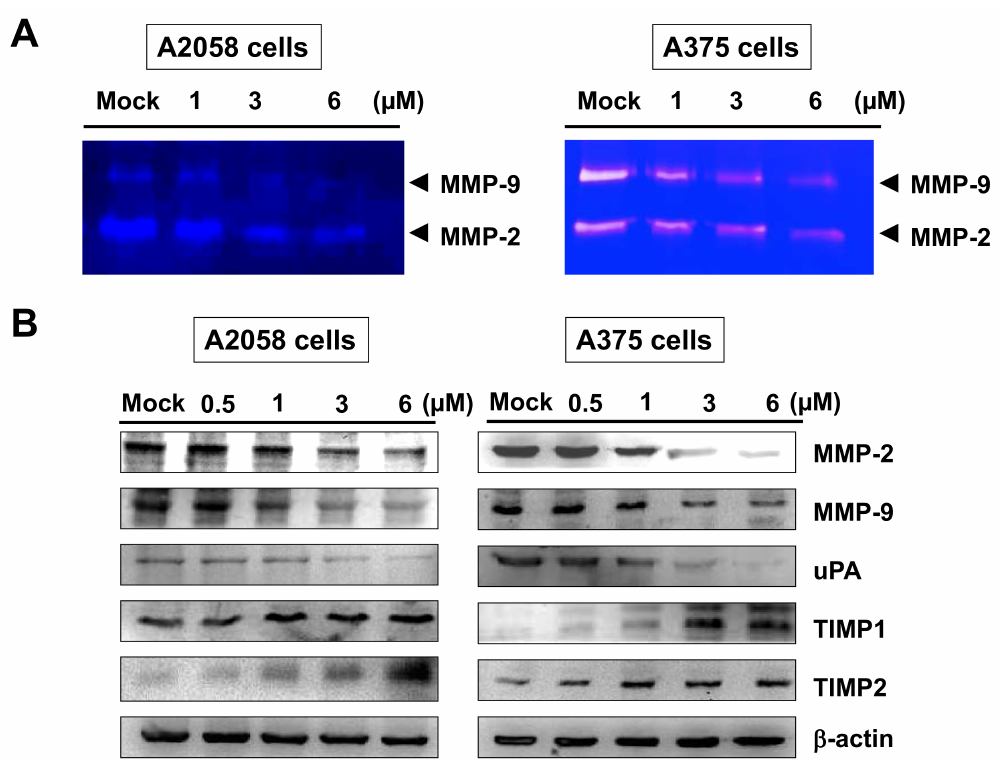
Figure 4. Effects of bornyl cis -4-hydroxycinnamate on the activities of MMP-2/-9 and protein levels in A2058 and A375 cells. A2058 and A375 cells were treated with different concentrations of bornyl cis -4-hydroxycinnamate (0, 1, 3, 6 µ M) for 24 h, and conditioned media and cell lysates were collected for analysis. ( A ) Gelatin zymography showed that bornyl cis -4-hydroxycinnamate inhibited MMP-2/-9 activities in A2058 and A375 cells in a dose-dependent manner; ( B ) The expression levels of MMP-2/-9-related proteins, including MMP-2, MMP-9, uPA, TIMP-1, and TIMP-2, were validated by western blotting. In order to observe the effect of these proteins associated with bornyl cis -4-hydroxycinnamate at low concentrations, a 0.5 µ M treated group was added. The results showed decreased MMP-2/-9 and uPA protein levels and increased TIMP-1 and TIMP-2 protein levels in A2058 and A375 cells after bornyl cis -4-hydroxycinnamate treatment. β -actin was used as the protein loading control. Mock: cells treated with vehicle control